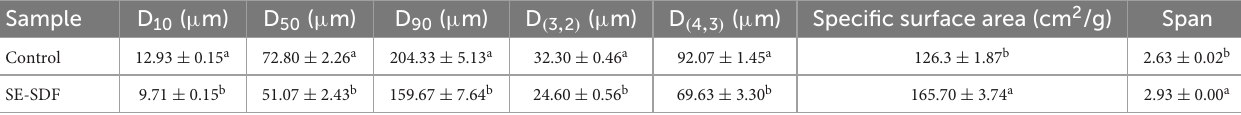
TABLE 3 Particle size distributions of soluble dietary fiber (SDF) from adlay bran.